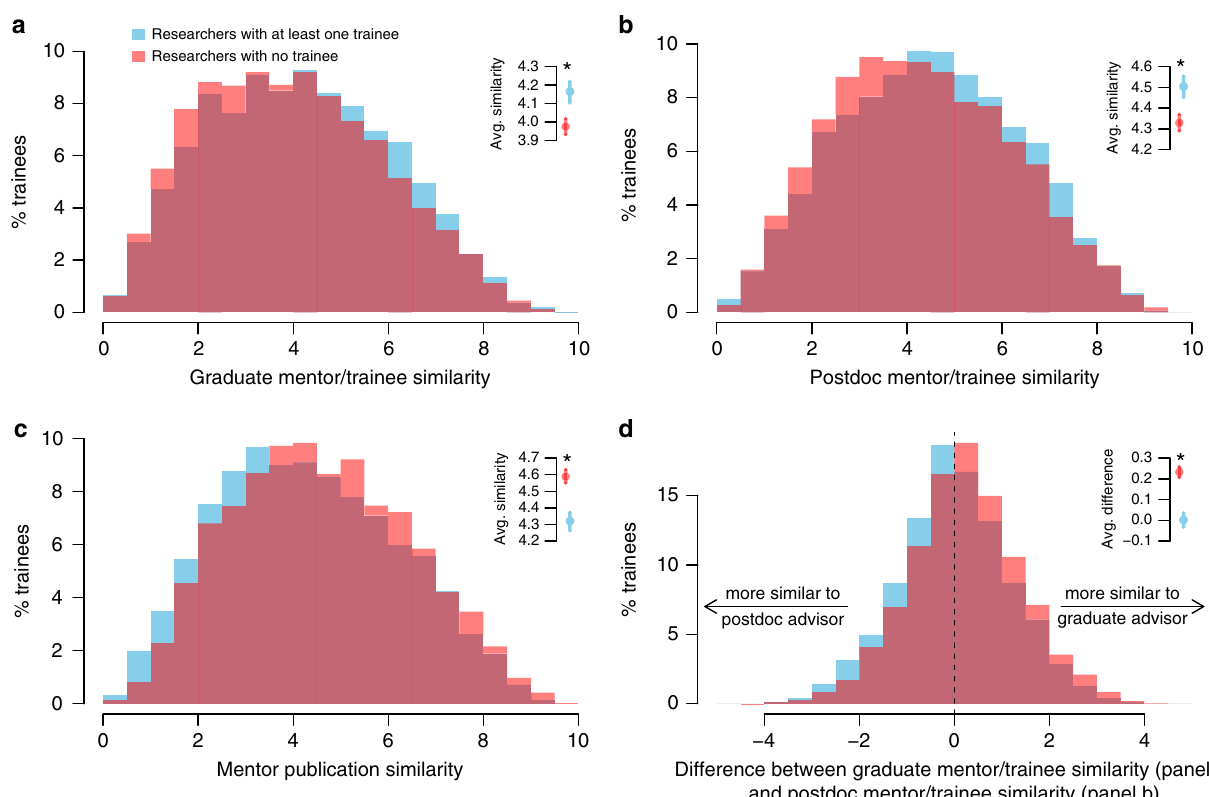
Fig. 3 The odds of becoming an academic mentor are correlated with a trainee ’ s ability to synthesize disparate in fl uences from their own mentors, as measured by the semantic similarity of their abstracts published prior to the end of postdoc training. Insets indicate the mean of the two trainee groups, i.e., those who do and do not become academic mentors, and 95% con fi dence intervals. a , b Trainees who become mentors show greater similarity with their graduate (A) and postdoctoral (B) advisors. c Lower similarity between these mentors is also linked with better odds to continue in academic research. d protégés that have a greater publication proximity with their postdoc mentor, compared to their graduate mentor, tend to move to independent academic positions more